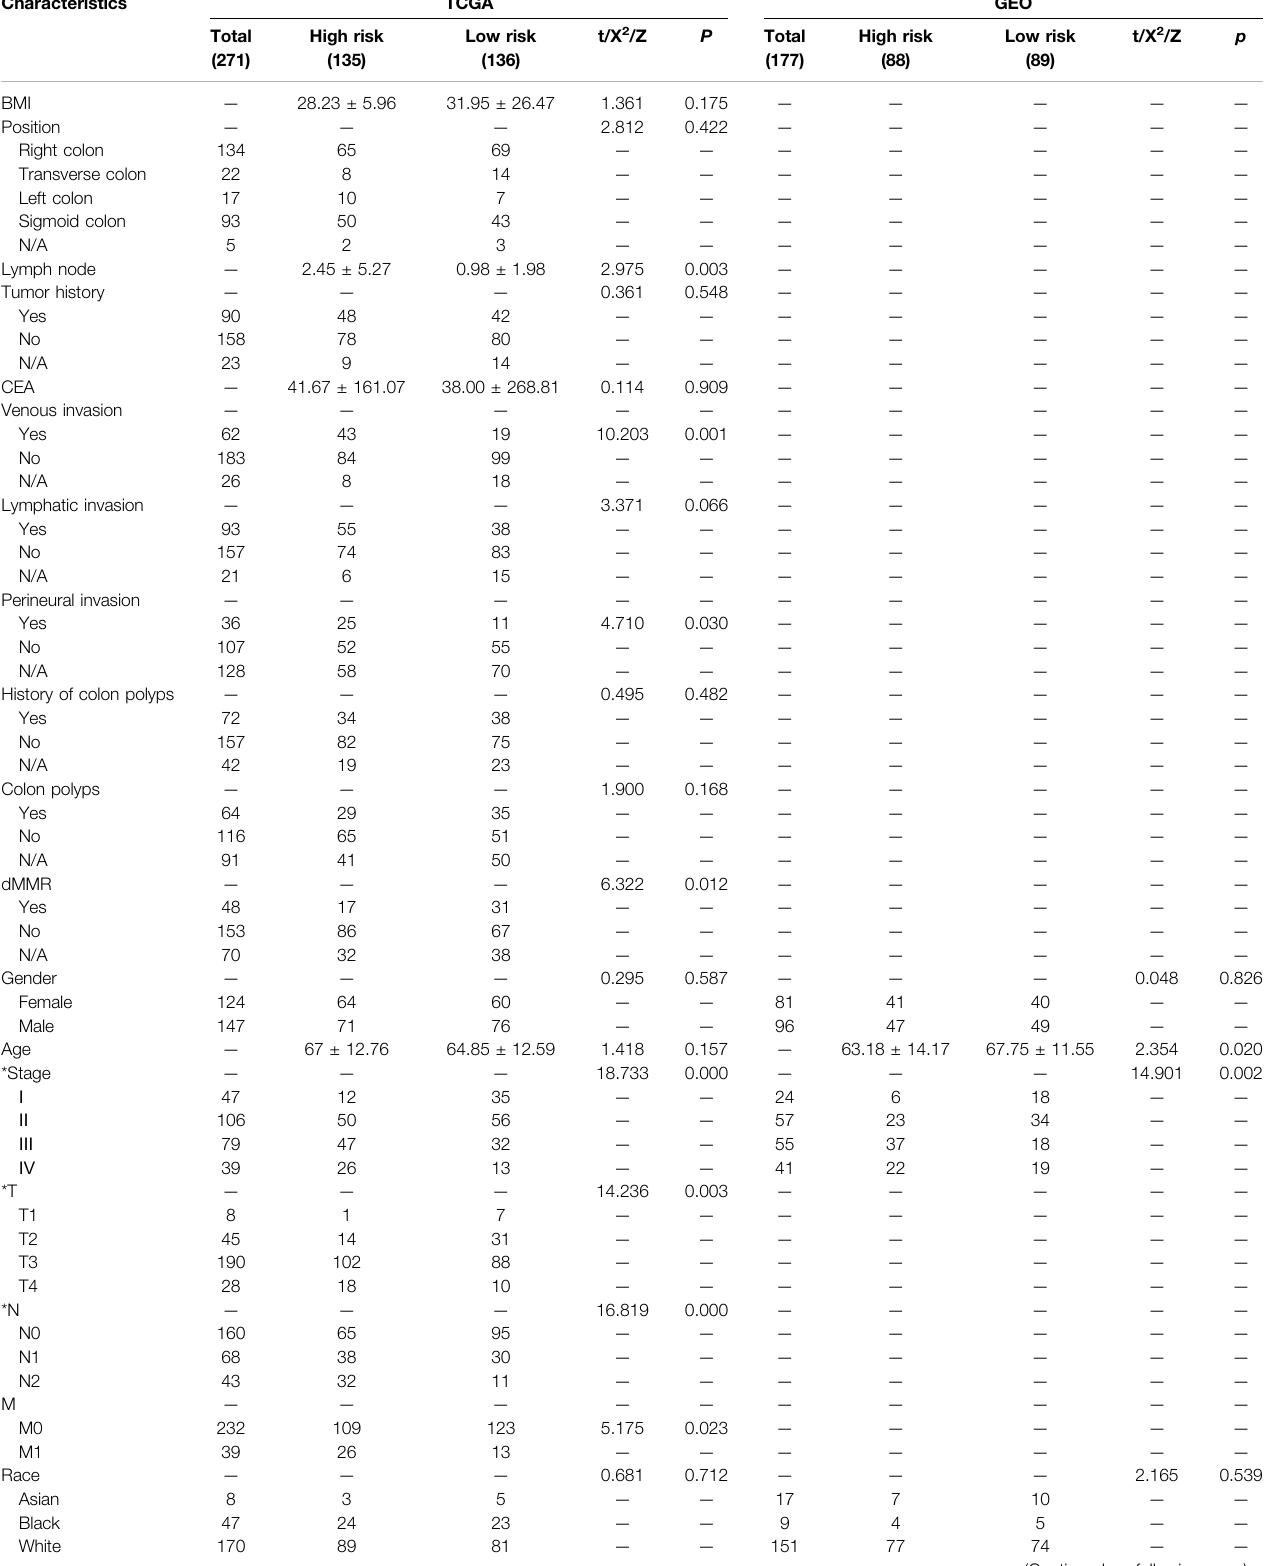
TABLE 1 | Different characteristics between low- and high-risk groups in the training (TCGA) and validation (GEO) sets. Characteristics